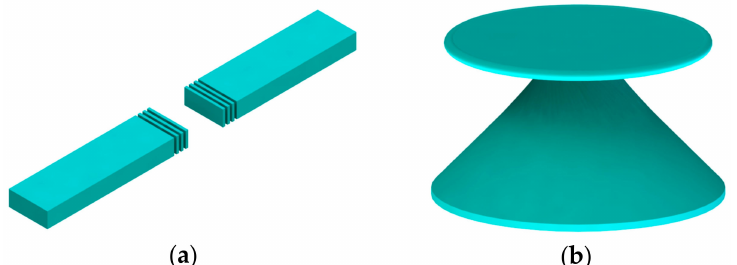
Figure 4. ( a ) Schematic diagram of Fabry-P é rot (F-P) cavity with DBRs; ( b ) schematic diagram of whispering gallery mode (WGM)